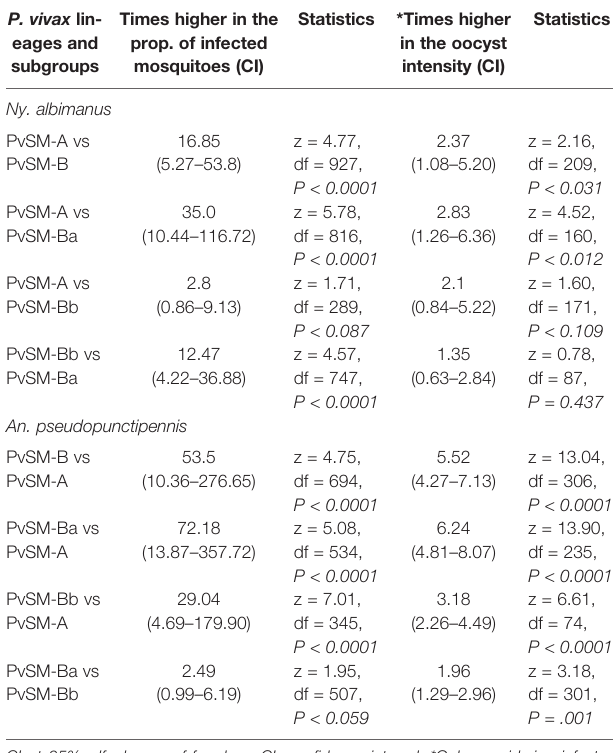
TABLE 5 | Statistics of the comparison of mosquito species infection rate and oocyst intensity between P. vivax lineages and